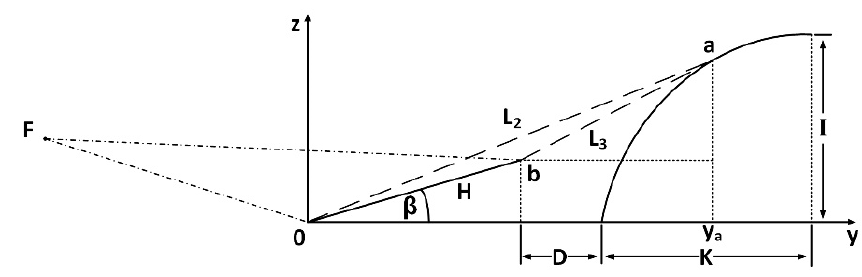
Figure 12. Convex roof behind a